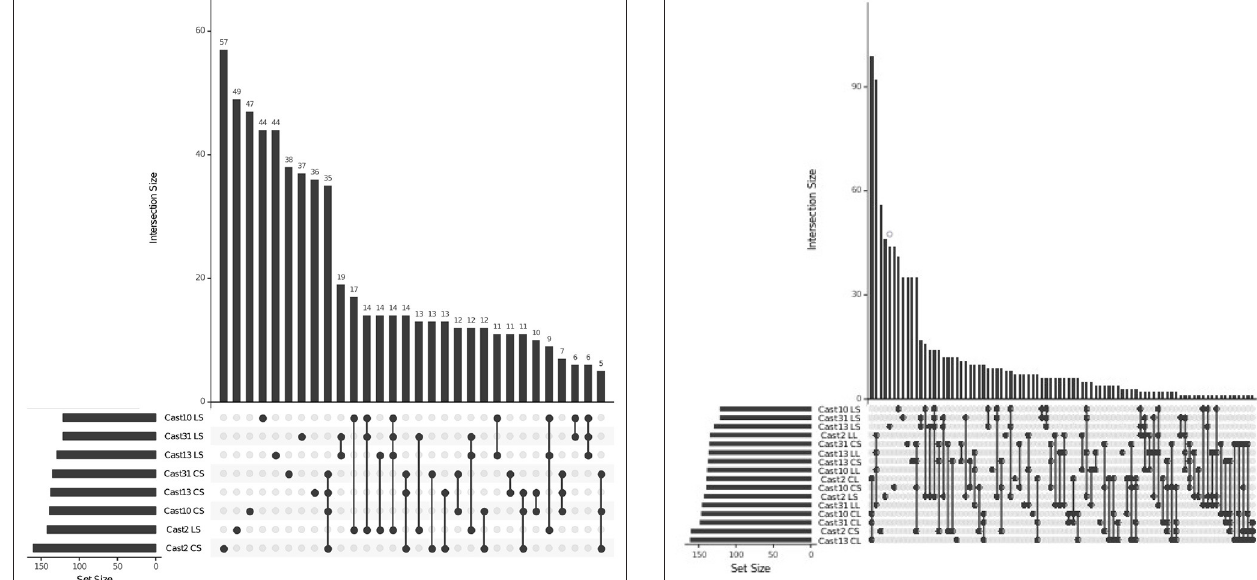
FIGURE 7 | Loci silenced across T. castellanus individuals. Set IDs represent samples where either T. crocifolius (C) or T. lamottei (L) homoeologs are silenced (S). Overlapping sets are indicated by filled circles, and the number of loci within that intersection may be seen directly above in the bar chart with corresponding size over each bar. The total sample sizes are found in the left bar chart and correspond to the adjacent sample. As expected, there should be no overlap across T. crocifolius and T. lamottei homoeologs.